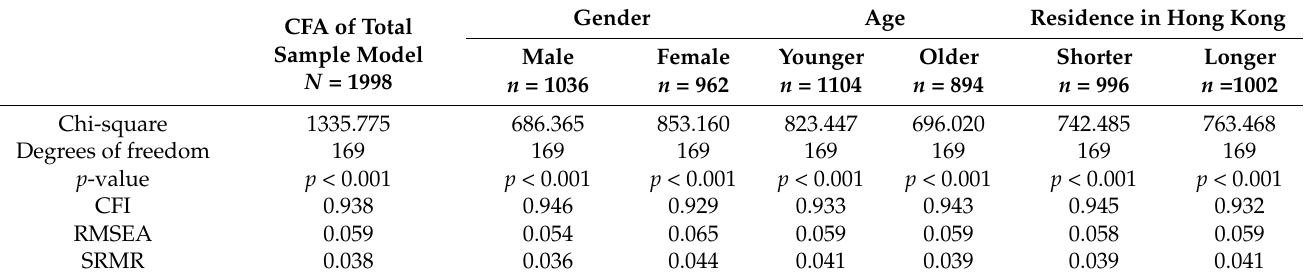
Table 3. Factorial validation in subsamples according to gender, age, and years of residence in Hong